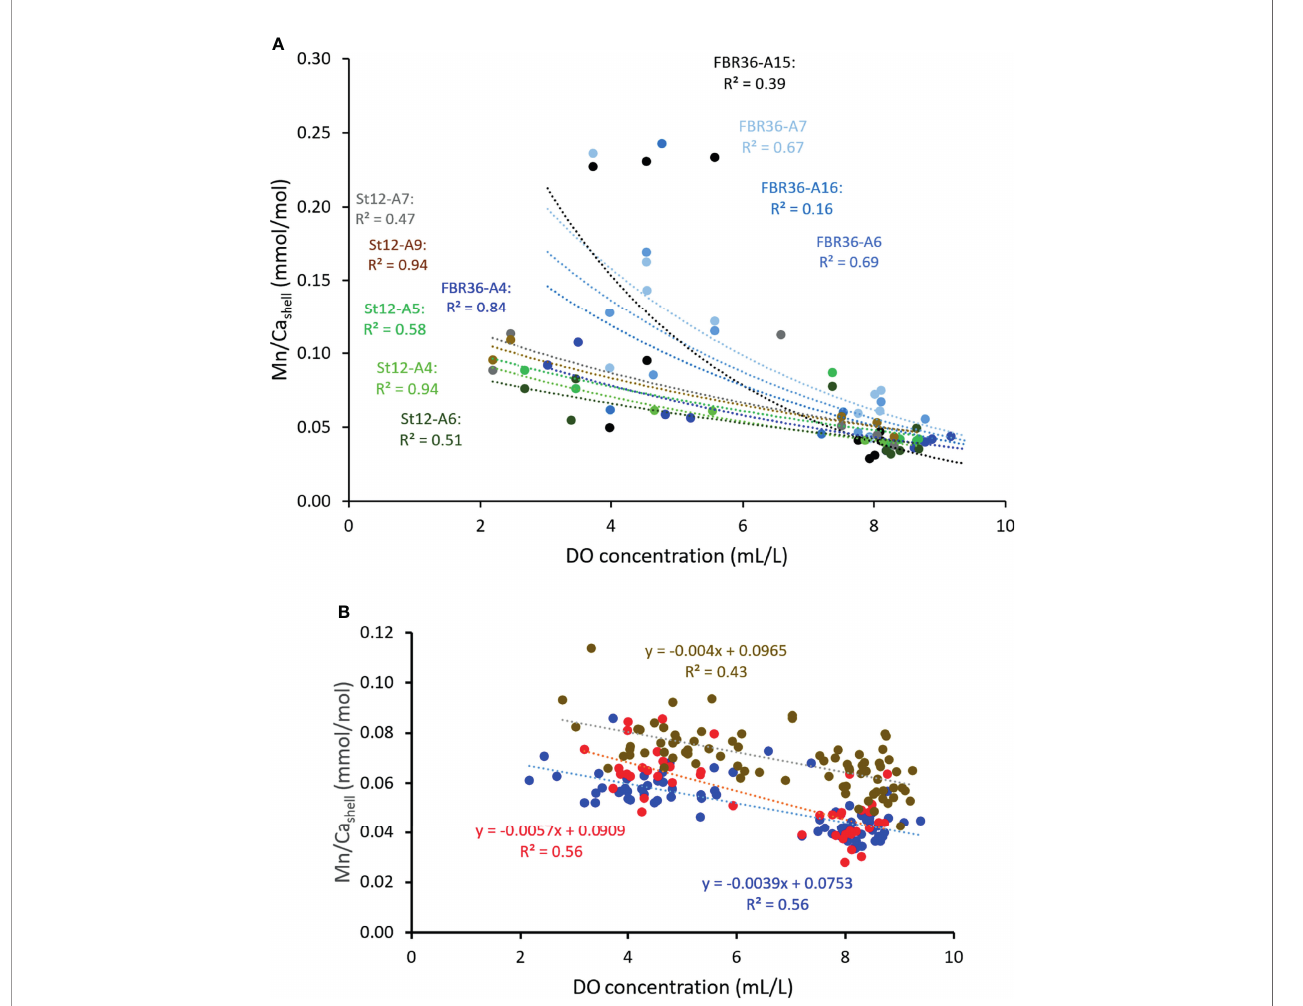
FIGURE 11 | (A) During early ontogeny (below age 10), Mn/Ca shell revealed non-linear relationships (here exponential fi ts used), even after double-detrending (= correlation between Mn/Ca shell with both annual growth rate and Mg/Ca shell mathematically eliminated). Signi fi cance levels were determined on the basis of linear regression models. Accordingly, except for specimens FBR36-A16 and St12-A7, all correlations were highly signi fi cant at p < 0.05. Trends varied between specimens, not localities. St12 = Mecklenburg Bight, FBR36 = Fehmarn Belt. (B) If the data from shell portions formed prior to age 10 were omitted, the relationship between Mn/Ca shell of A. islandica and DO concentration measured some decimeters above sea fl oor became much stronger. All correlations were highly signi fi cant at p < 0.0001. (Compare Figure 10C